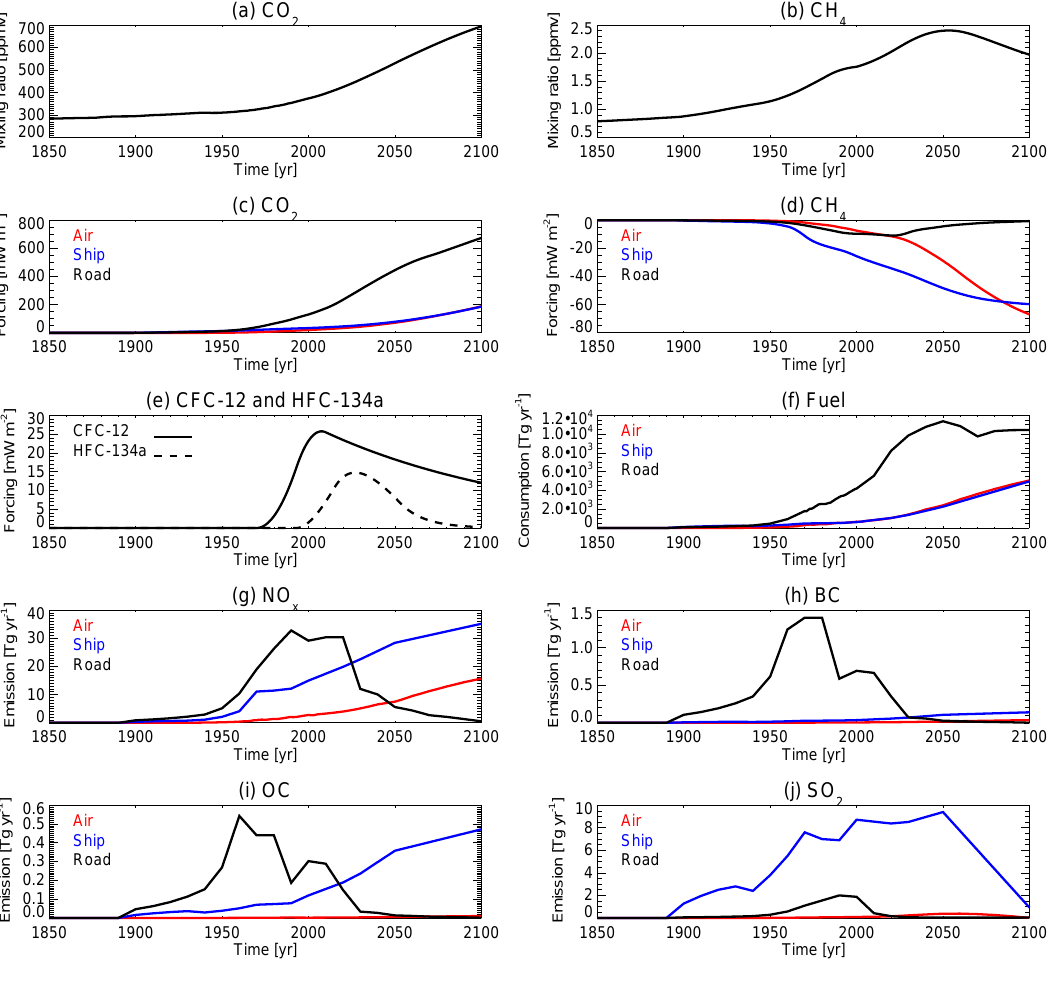
Fig. 2. Global maps of the annual CO 2 emission estimates (in gram[CO 2 ] m − 2 yr − 1 ) for the year 2000 from road transport (left), maritime shipping (middle) and aviation (right). For more details, see Borken et al. (2007), Endresen et al. (2003), Lee et al. (2010), and http: //www.ip-quantify.eu/.